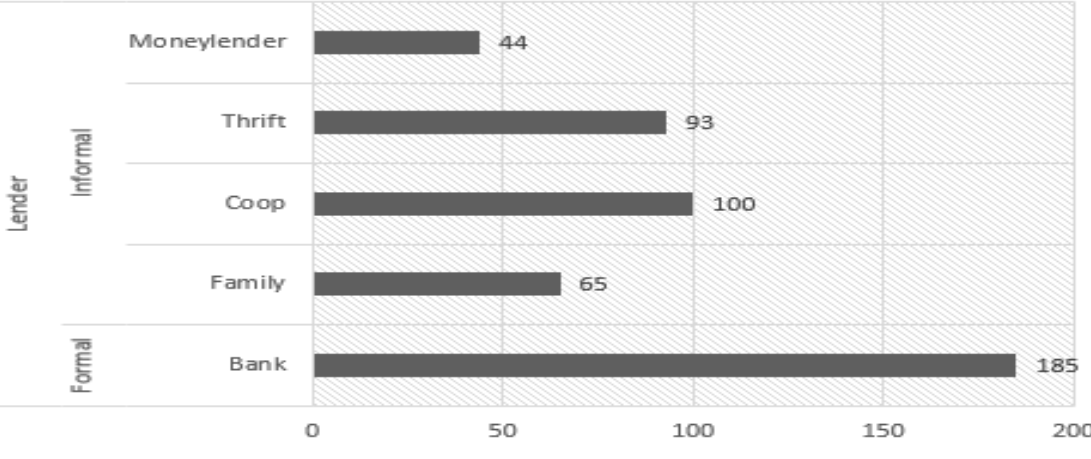
Figure 1 : Distribution of loans by individual